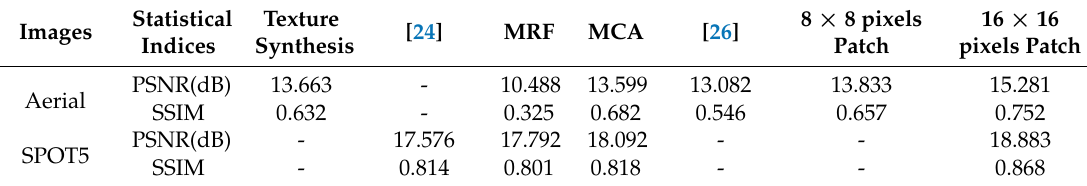
Figure 6. Comparison of Visual Effects on SPOT5 Panchromatic Imagery. ( a ) Original SPOT5 Image; ( b ) Corrupted by Simulated Clouds; ( c ) Result of Proposed Method; ( d ) Result of MCA; ( e ) Result of MRF; ( f ) Result of Exemplar-based. Table 2. Comparisons of Statistical Indices on Aerial and SPOT5